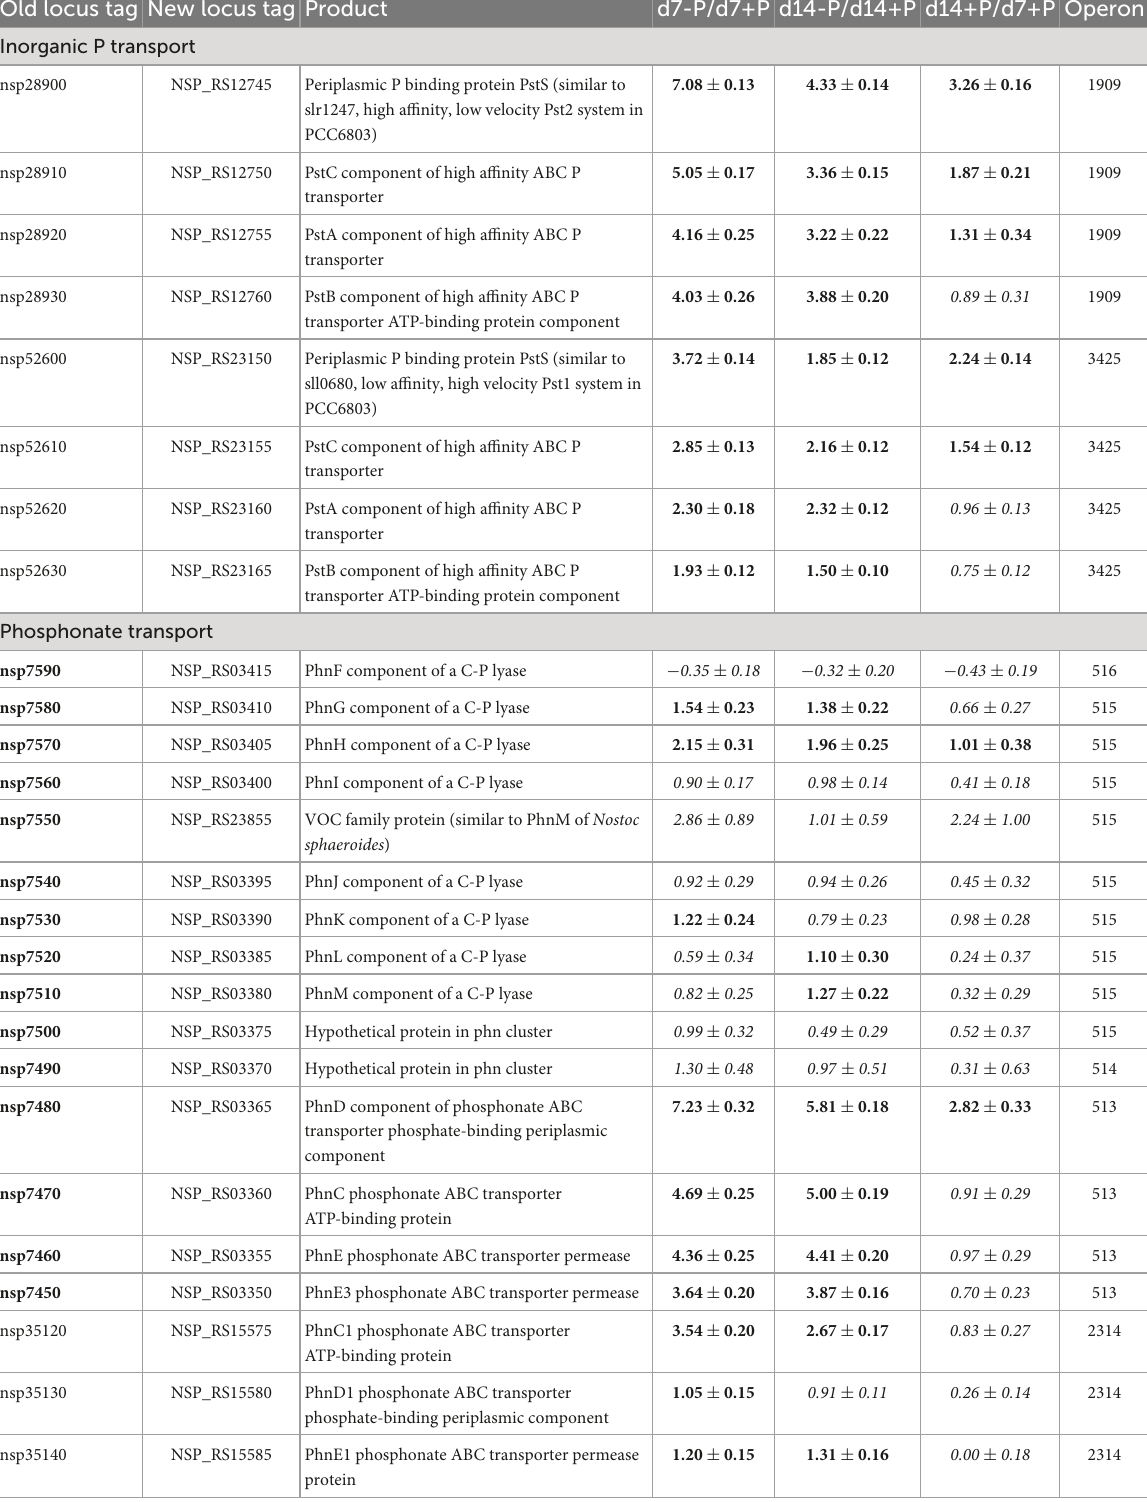
TABLE 1 P-related genes in Nodularia spumigena CCY9414 according to Voss et al. (2013) and their differential expression after 7 or 14 days of P-limitation as well as during growth for 14 days in P-replete medium. Old locus tag New locus tag